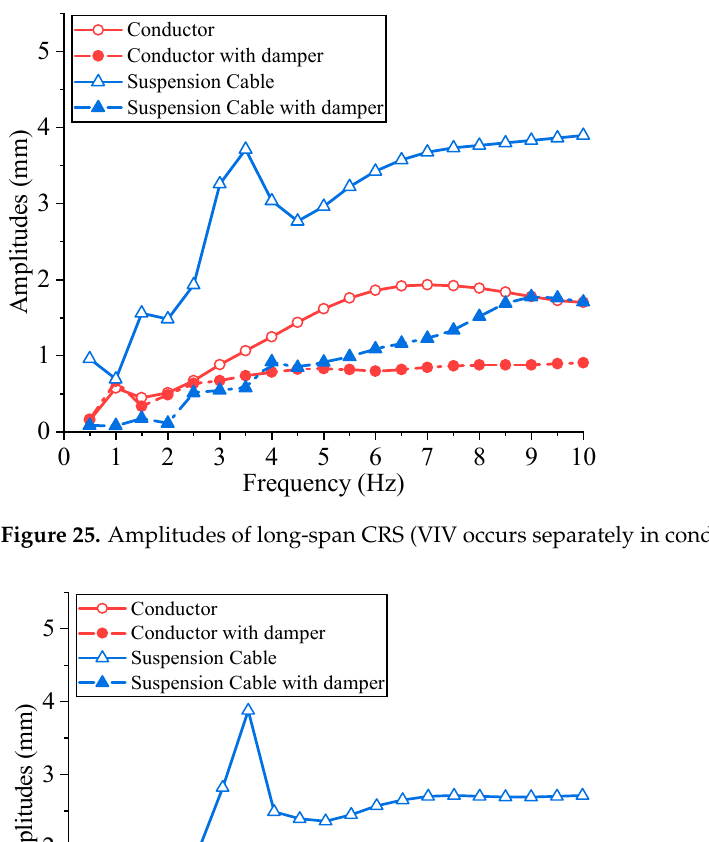
Figure 25. Amplitudes of long-span CRS (VIV occurs separately in conductor or cable).